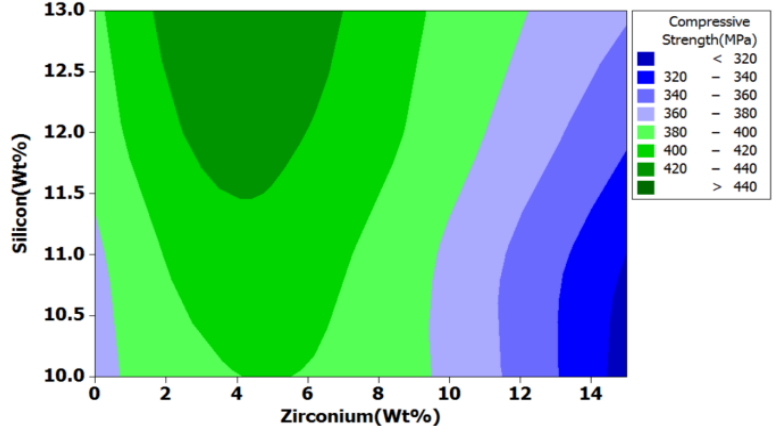
Figure 16. Compressive strength contour plot.